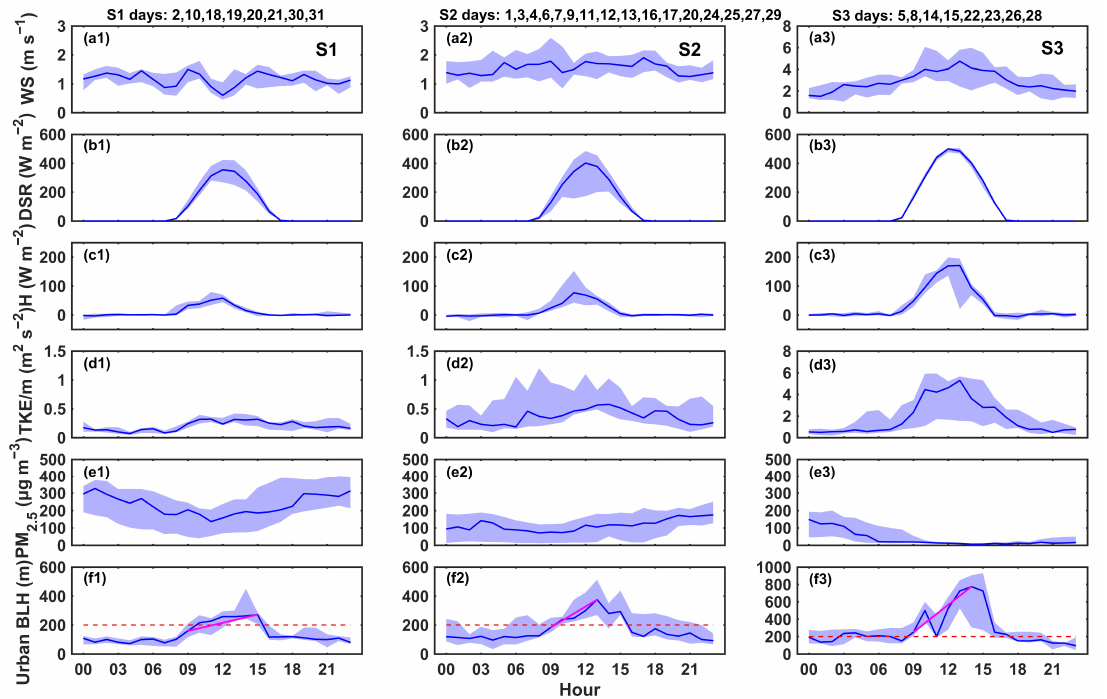
Figure 7. Mean diurnal cycles of downward shortwave radiation (DSR), sensible heat flux, PM 2.5 concentration, and urban BLH under low ( a1 , b1 , c1 , d1 , e1 , f1 ), moderate ( a2 , b2 , c2 , d2 , e2 , f2 ), and strong ( a3 , b3 , c3 , d3 , e3 , f3 ) wind classes. The shaded areas, blue solid line, red dashed line, and pink lines correspond to the interquartile range (25%–75%), median, 200 m (definition of onset the convective boundary layer), and the slopes of growth rate of the median value of urban BLH from 09:00 CST to the peak time,